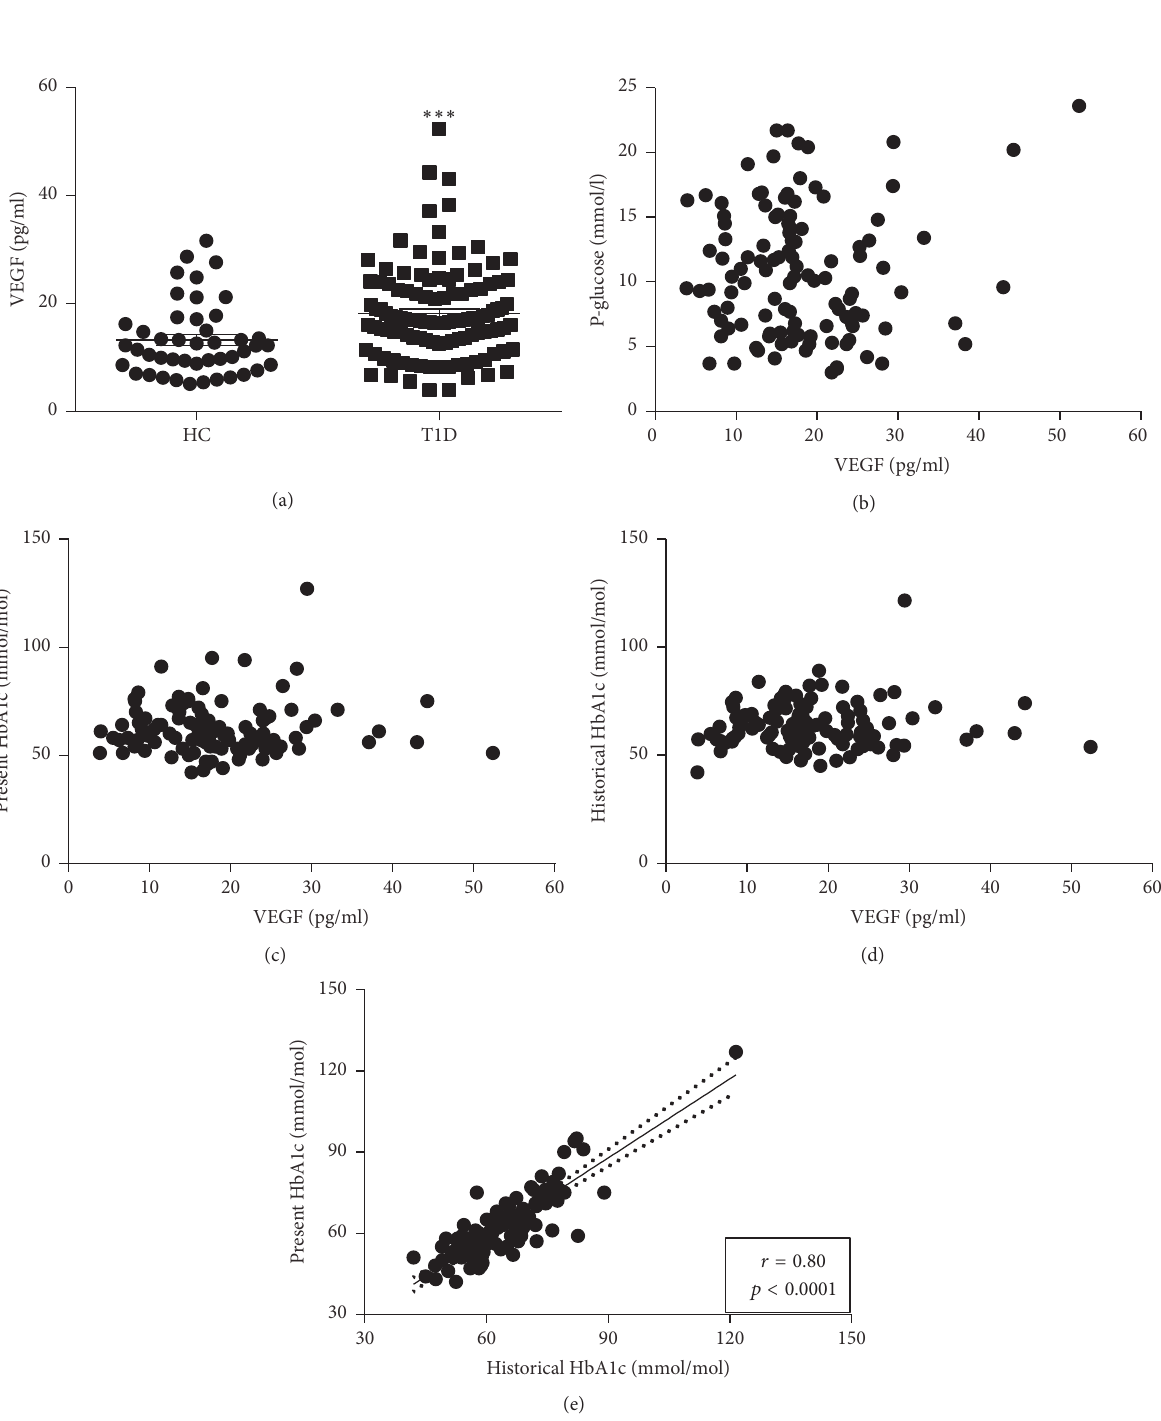
Figure 1: Increased levels of plasma VEGF in type 1 diabetes do not correlate to metabolic control. (a) The circulating levels of VEGF in plasma were increased in patients with long-standing ( > 10 years) type 1 diabetes (T1D, 𝑛 = 115 ) when compared to matched healthy controls (HC, 𝑛 = 45 ). In T1D patients there was no correlation between the plasma levels of VEGF and fasting plasma glucose (b), present HbA1c levels (c), or the average historical HbA1c levels from the last 10 years (d). However, there was a positive correlation between average historical and present metabolic control (e). An unpaired two-tailed 𝑡 -test based on ranks (Mann–Whitney) was applied in (a) since VEGF was not normally distributed. Values are given as mean ± SEM. All correlations were calculated using nonparametric Spearman correlation. ∗ ∗ ∗ denotes 𝑝 < 0.001